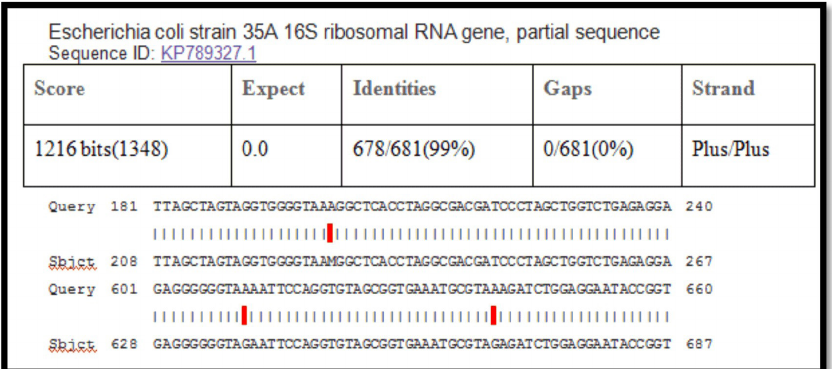
Fig. 7. Sequence analysis of 16S rRNA gene E.coli